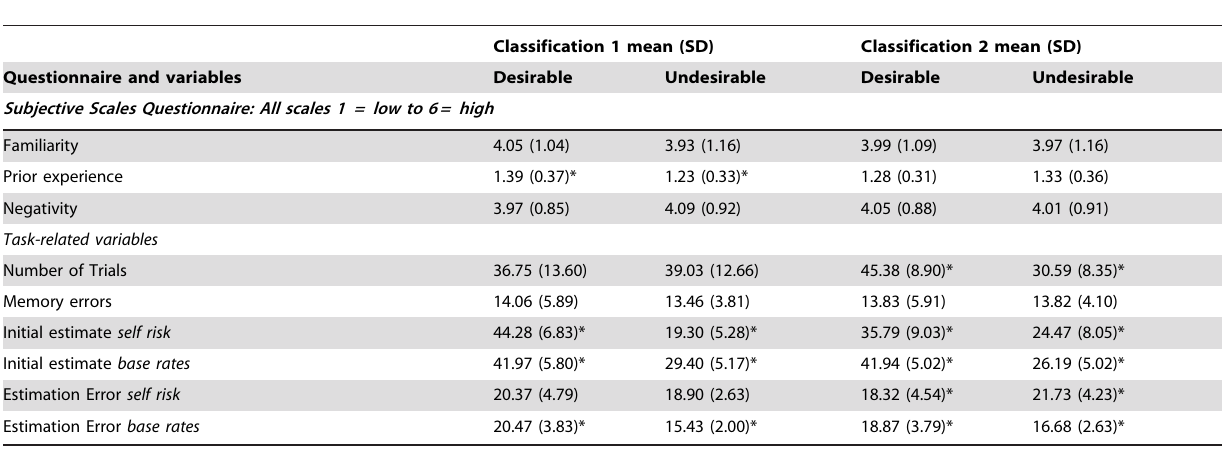
Table 1. Participants’ ratings of familiarity, prior experience, negativity, memory errors, initial estimates, number of trials and estimation